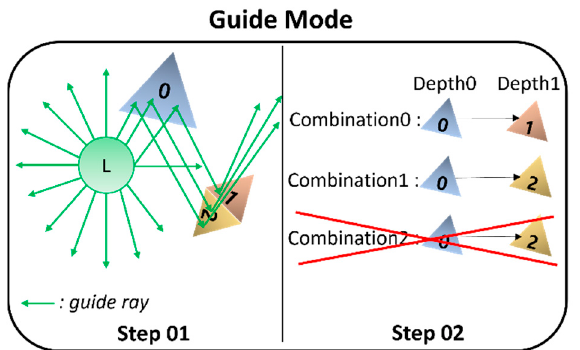
Figure 7. Description of G mode: Find combinations of hit-triangles through guide ray (Step 01) and remove duplicate combinations among combinations using a merge sort (Step 02).